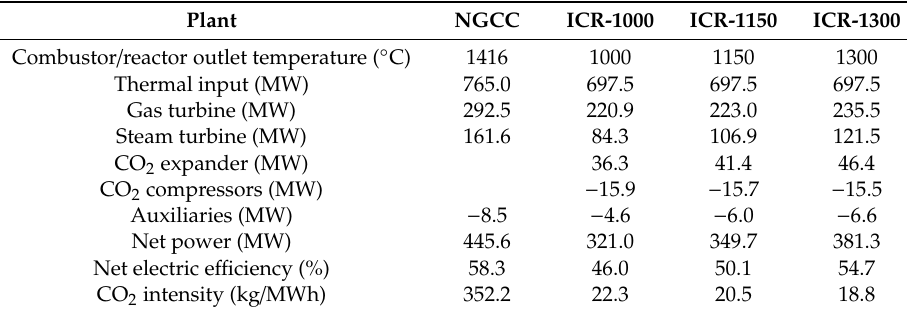
Table 3. Performance of the di ff erent plants evaluated in this study.